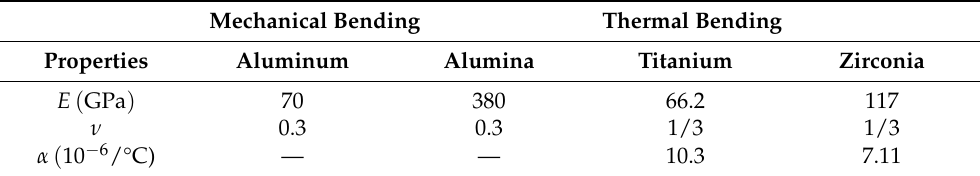
Table 1. Material properties used in the FG nanoplate.